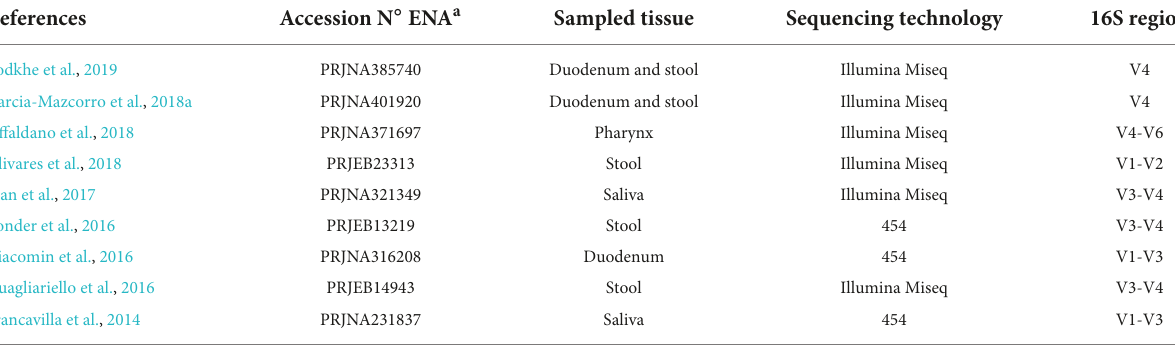
TABLE 1 The number of samples for each study, clinical classification, and tissue of origin for the data included in the analysis.